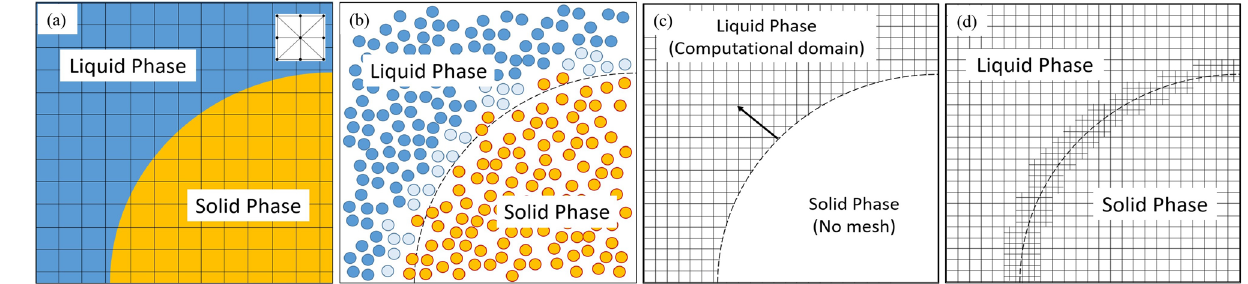
Figure 1. Schematic representation of the fluid–solid interface using different methods for pore-scale modeling of mineral dissolution or precipitation process ( a ) LBM ( b ) SPH ( c ) ALE ( d )